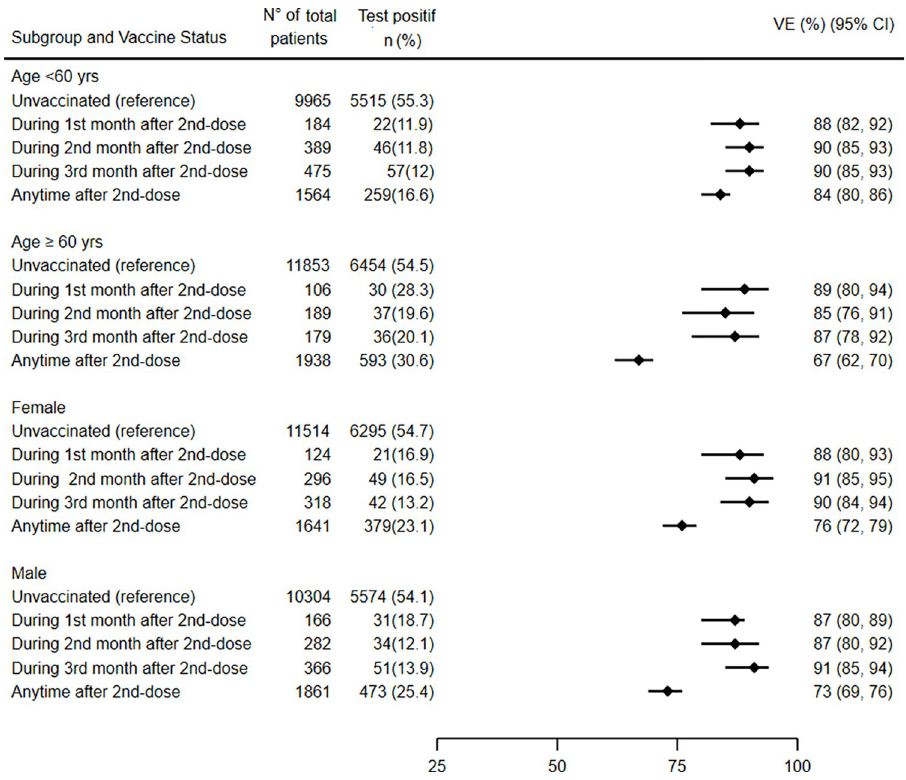
Fig 4. Estimates Vaccine effectiveness of inactivated vaccine BBIBP-CorV against COVID-19-associated severe or critical hospitalization according to age and gender over time since second dose vaccination.